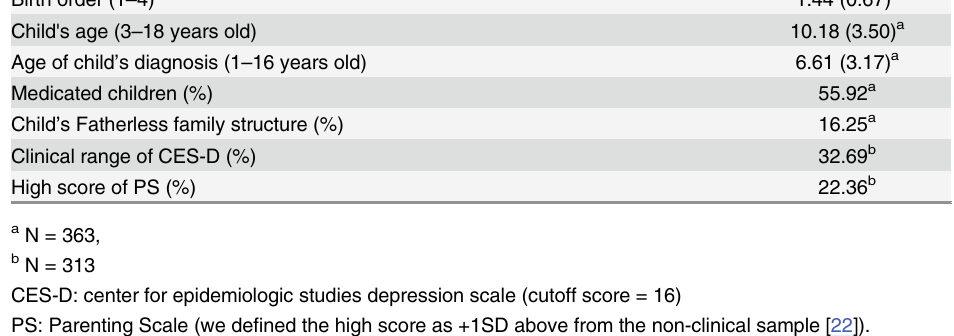
CES-D: center for epidemiologic studies depression scale (cutoff score =